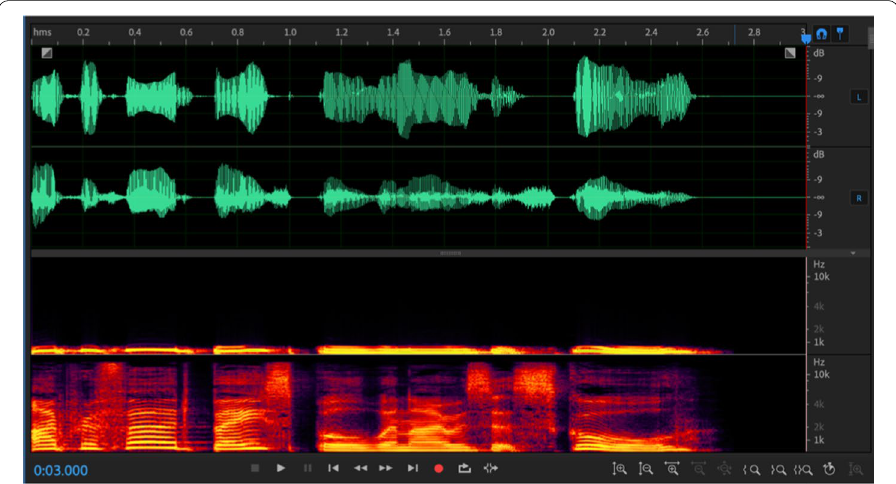
Fig. 1 Spectrogram of the FL-R stimulus “I preferred baseball when I was at